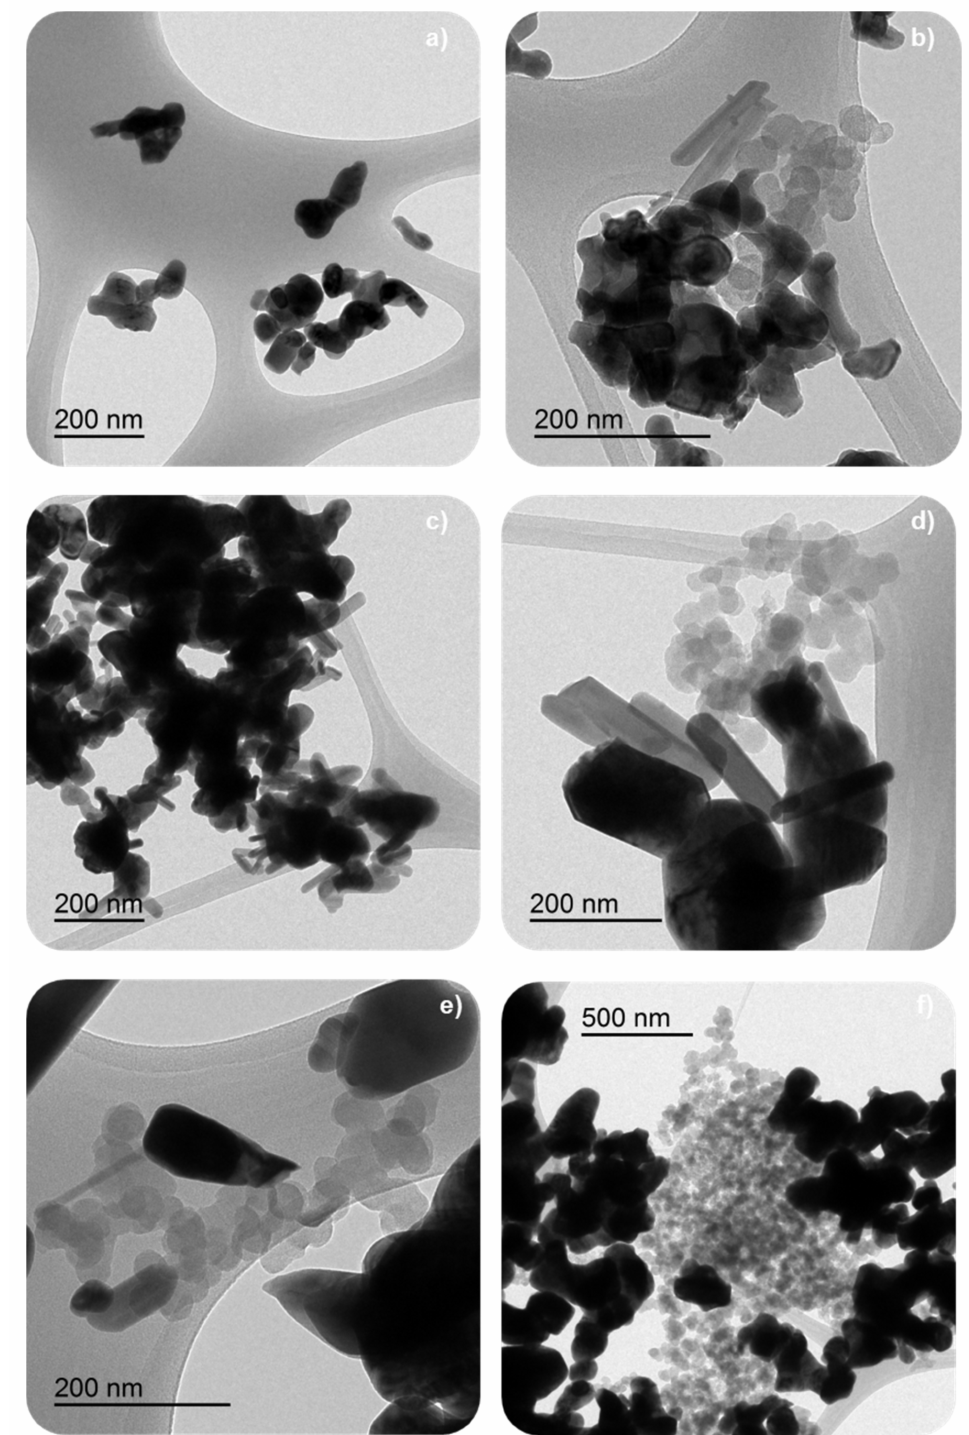
Figure 16. TEM images of selected BM-CX catalysts; from top to bottom ( a , b ) BM-C600, ( c , d ) BM- C700, and ( e , f ) BM-C850; after three NO x -TPR ( left column ) and two isothermal ( right column ) soot oxidation